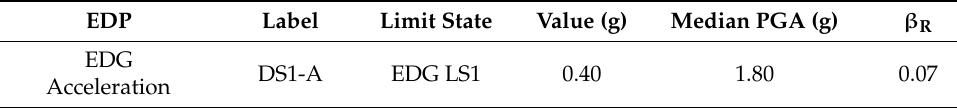
Table 6. IDA results for the EDG acceleration